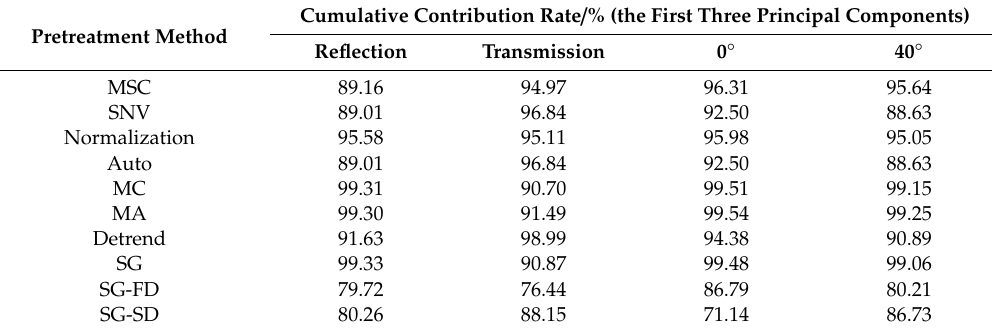
Figure 7. Cumulative contribution rates of the top 20 principal components in 0° incident light. Table 2. Cumulative contribution rates of the first three principal components.